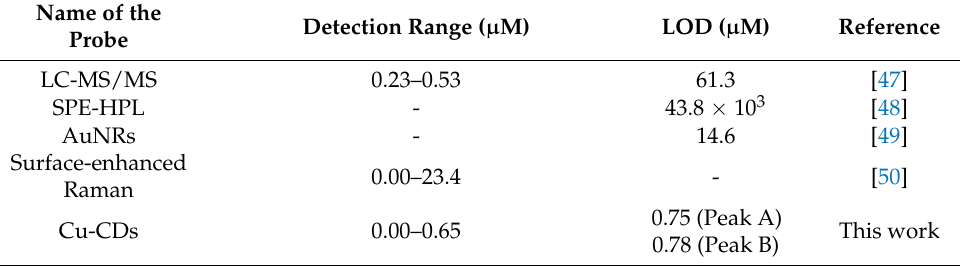
Figure 8. ( A ) Fluorescence emission spectra of Cu-CDs in the presence of TM, different colored lines from top to bottom represent 0–200 µ M TM concentrations; ( B ) three-dimensional fluorescence emission spectra with the fluorescence quenching degree at 375 nm ( C ) and 450 nm ( D ). Table 1. Results of our work are compared with the previous TM-detection methods. Name of